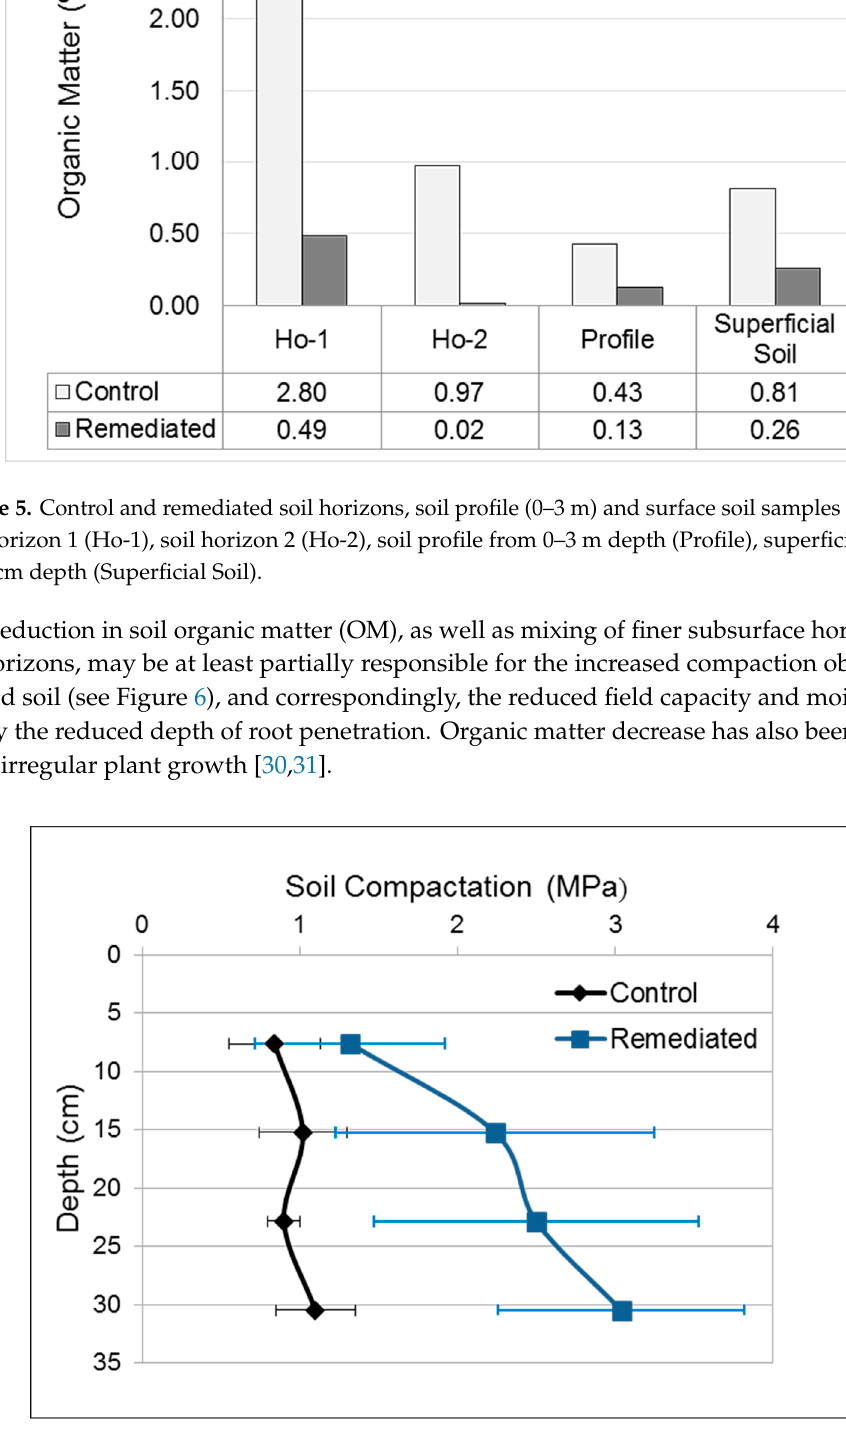
Figure 6. Control and remediated soil compaction, error bars represent one standard deviation.